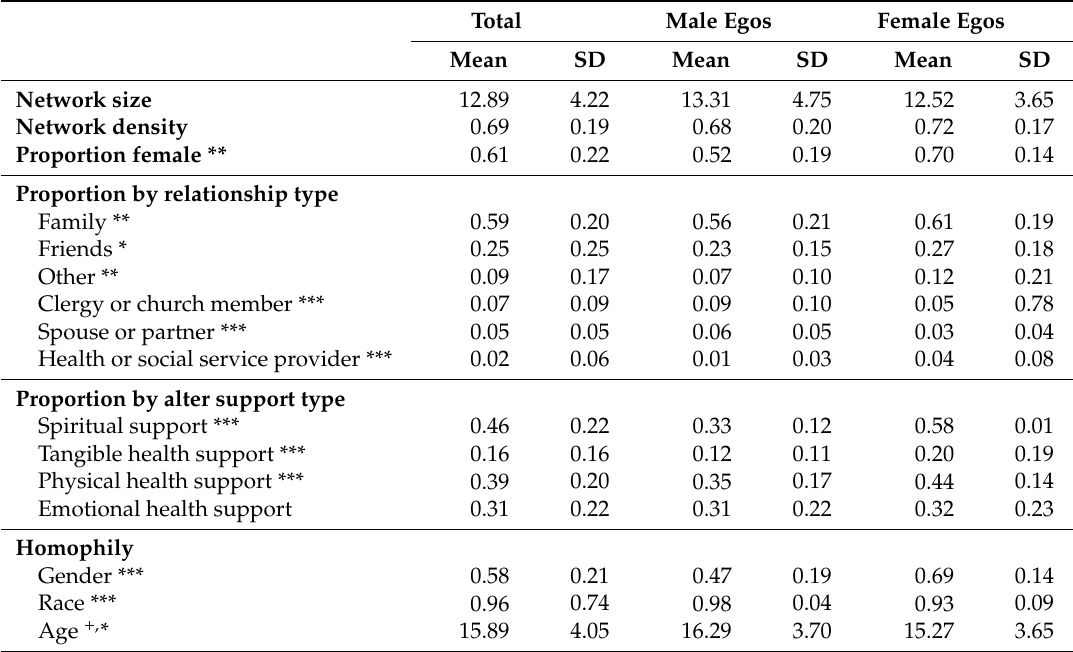
Table 3. Network level Descriptive Statistics by Ego Gender ( n =